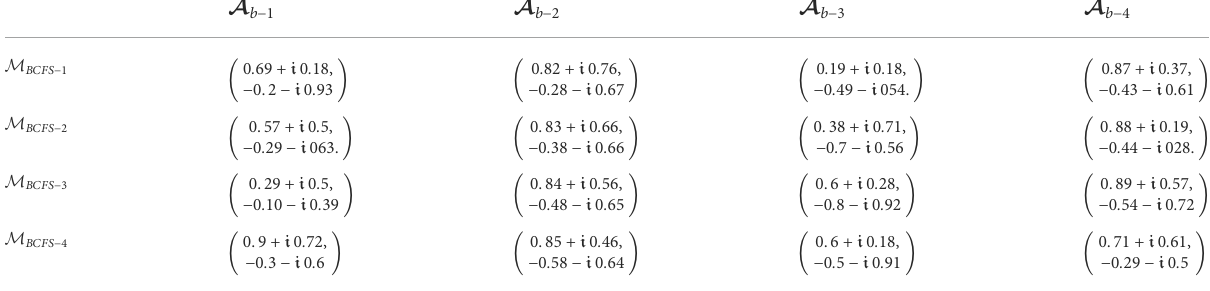
TABLE 1 Decision matrix containing BCFNs is provided by an